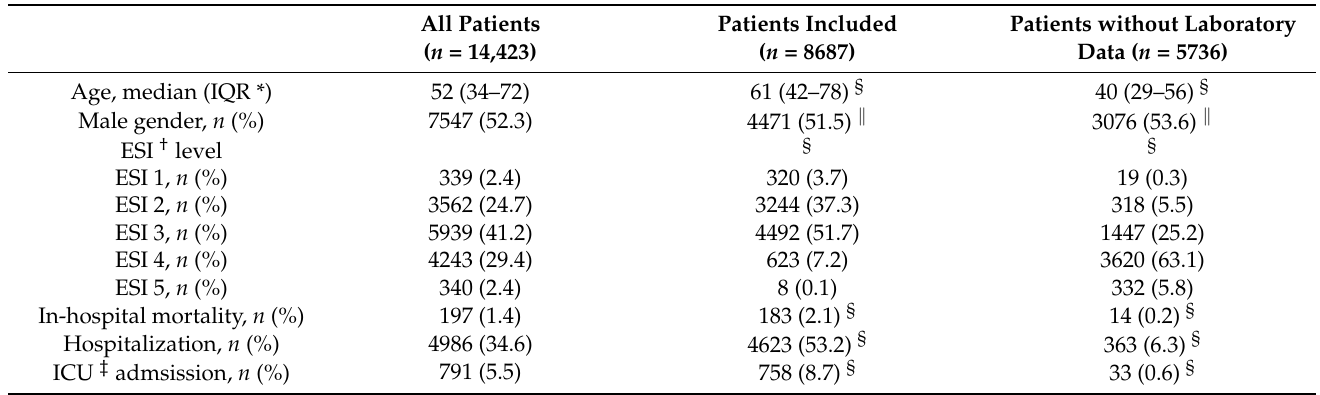
Table 1. Baseline characteristics and outcomes of patients included and patients without laboratory data.